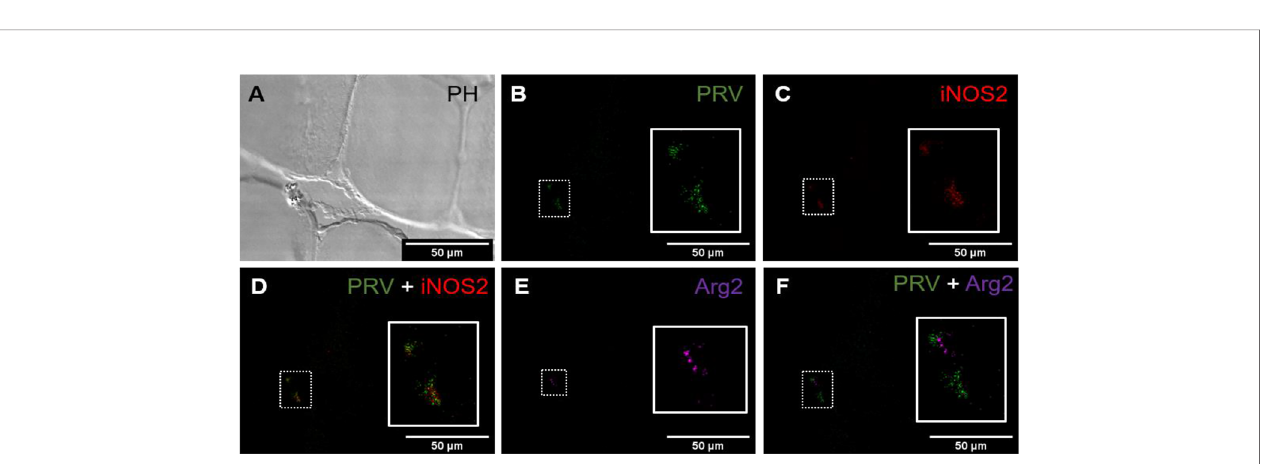
FIGURE 6 | Fluorescent in situ hybridization of PRV-1, iNOS2 and Arg2 in areas without spots, from PRV-1 infected fi sh. (A) Phase contrast image showing cells structure. (B) PRV-1 (green) speci fi c transcripts detected between muscle cells. (C) iNOS2 (red) positive cells in the same area as PRV-1. (D) Merged image showing co-localization of PRV-1 and iNOS2 (yellow, insert). (E) Arg2 (purple) positive cells were detected partly in same area as PRV-1. (F) Merged image of PRV-1 and Arg2 show Arg2 positive cells surrounding PRV-1 infected cells (inset). Scale bar = 50µm.